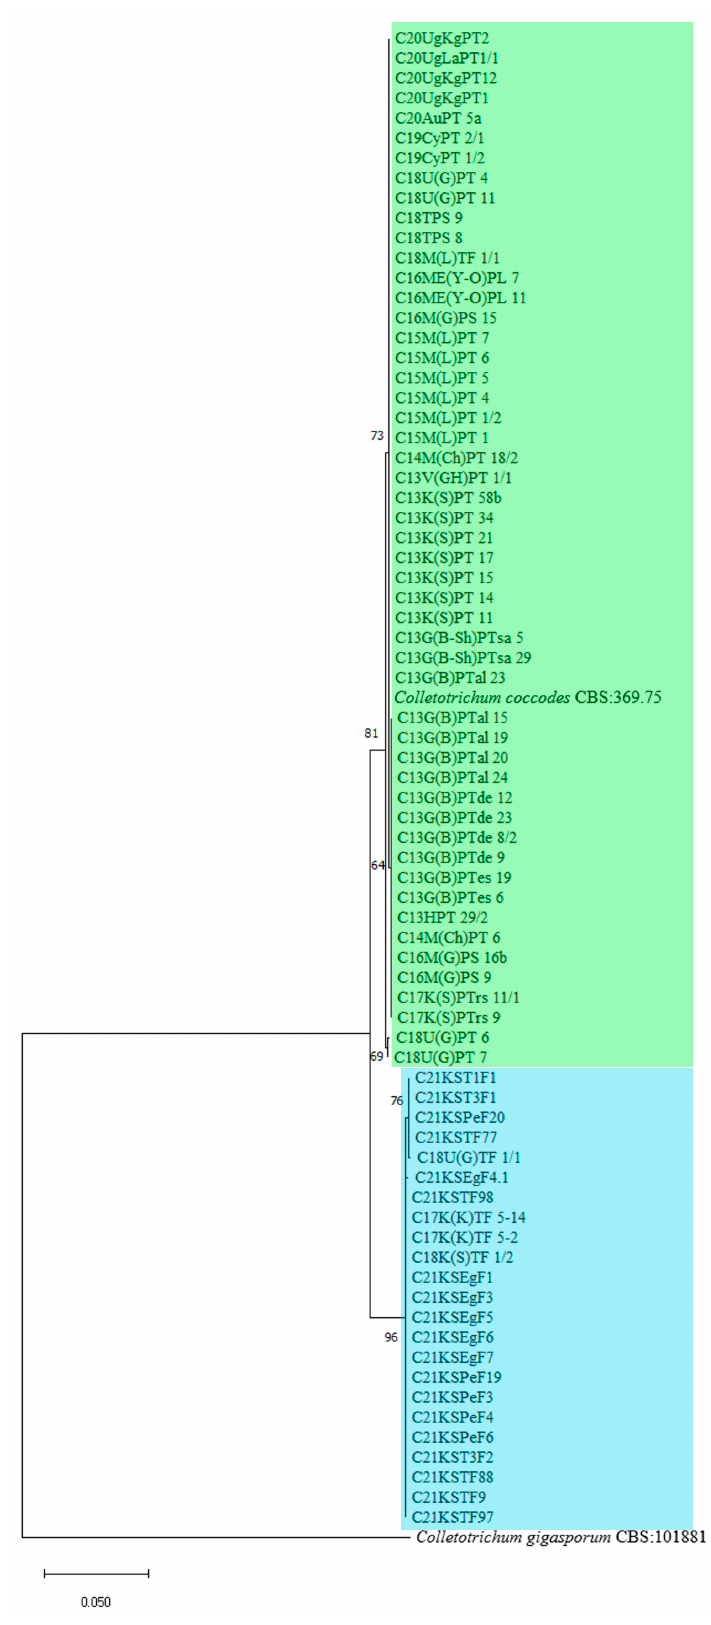
Figure 6. Phylogenetic tree inferred from maximum-likelihood analysis of the glutamine synthetase intron alignment. Bootstrap 1000 replicates. The confidence values are indicated at the branches. Green indicates C. coccodes clade; blue indicates C. nigrum clade.